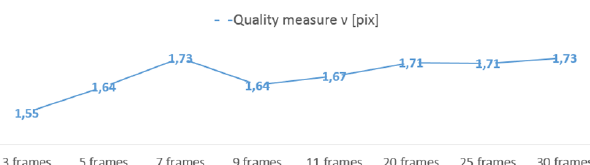
Figure 6: Quality measure ν calculated after tracking with vary- ing key-frame